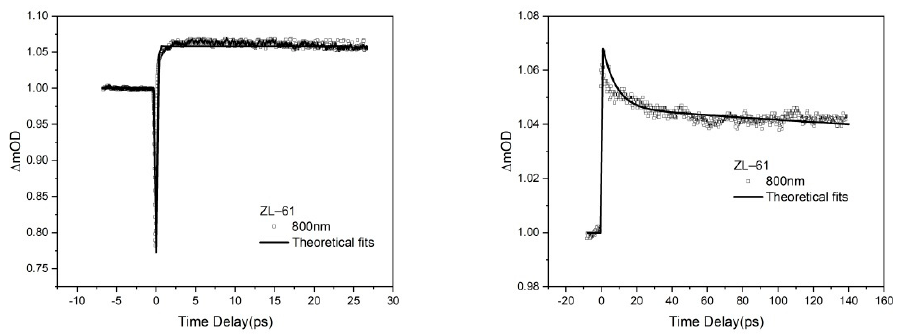
Figure 9. Photodynamic curves of ZL-61 in short-delay time and long-delay time at 800 nm.